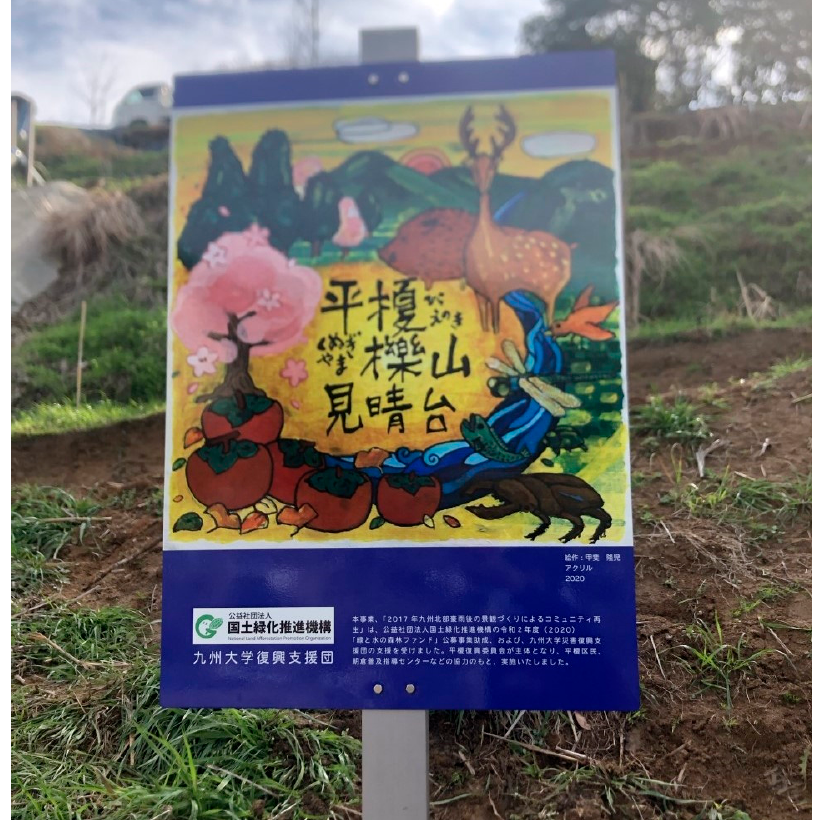
Figure 4. Signboard at the Kunugiyama observation site (obtained by Yoshio Harada [the first author] on 6 March 2021). The signboard notes that this project was led by the HRC and the community residents with support from Kyushu University Team, Asakura Extension Center, and the National Land Afforestation Promotion